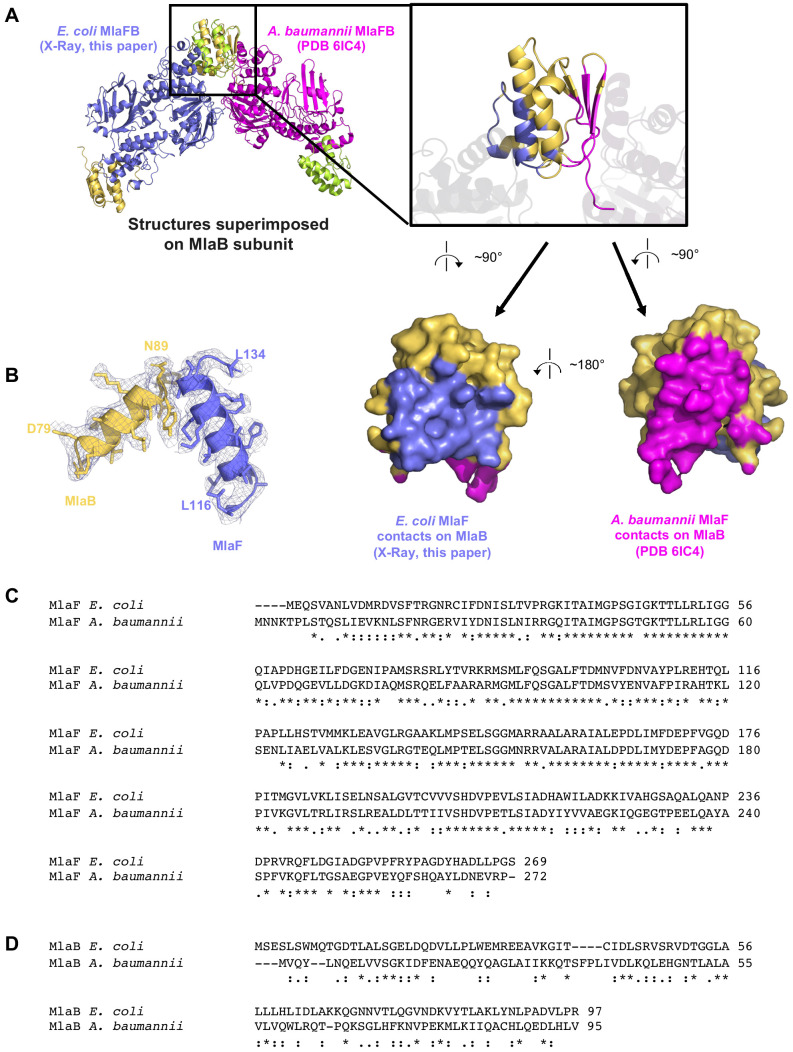
Comparison of our E. coli MlaFB crystal structure (2.60 Å resolution) and coordinates deposited for A. baumannii MlaFB from a cryo EM reconstruction (8.7 Å resolution).(A) E. coli X-ray structure and A. baumannii (PDB 6IC4) EM model aligned on MlaB. Inset shows interfaces mapped on both structures. (B) Electron density from our crystal structure, corresponding to helices and side chains at the interface between MlaF and MlaB. Sequence alignment of MlaF (C) and MlaB (D) from the two species.